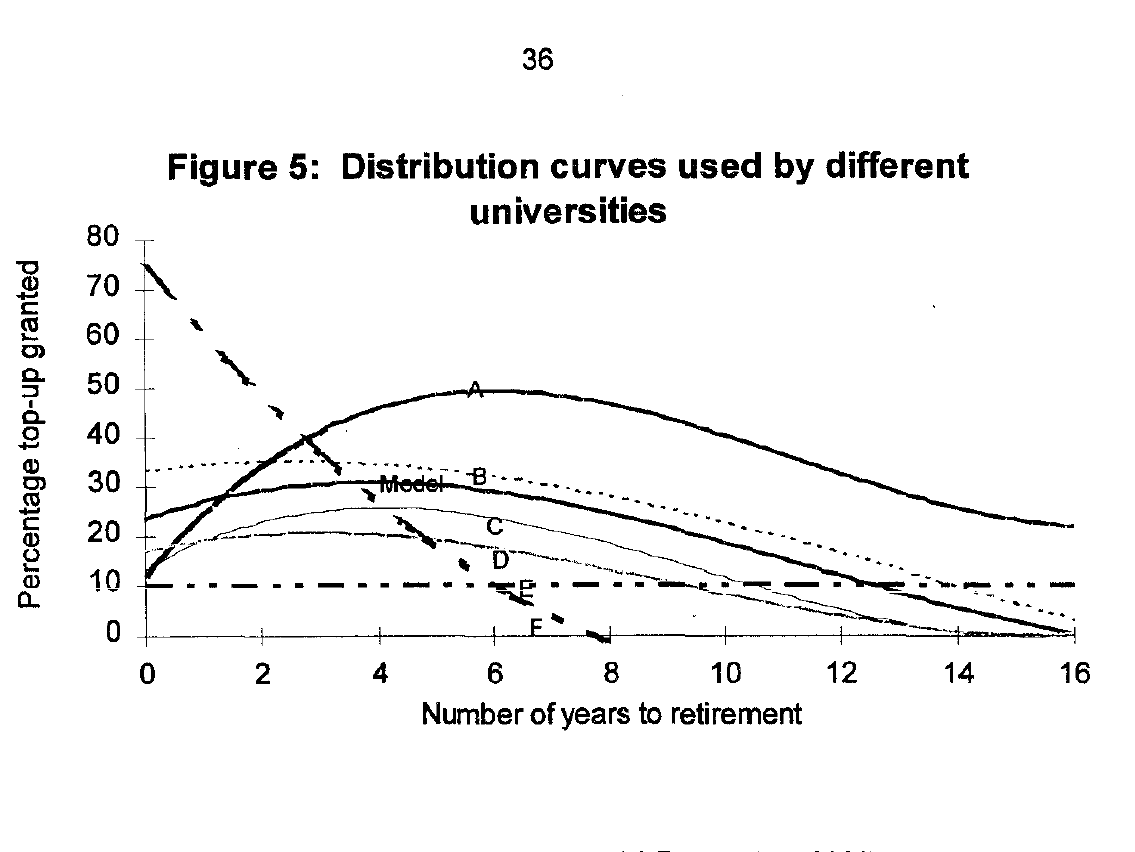
Figure 5: Distribution curves used by different